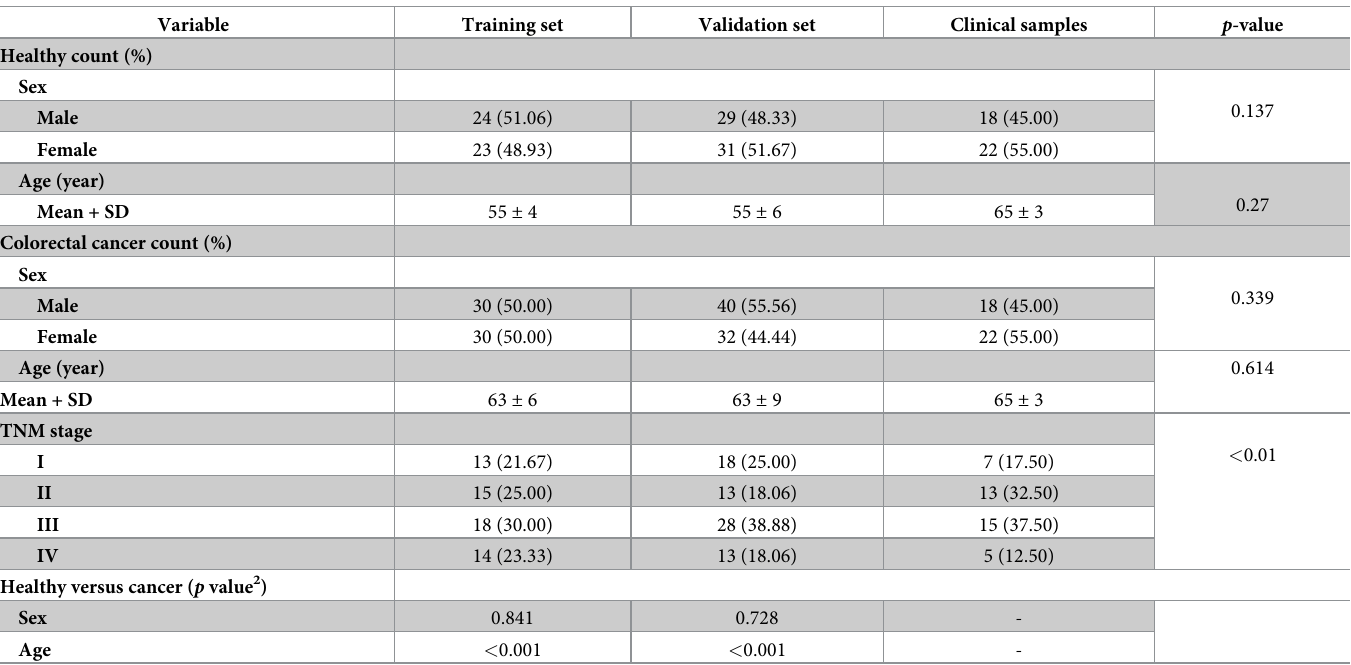
Table 2. Clinical features of the colon cancer group.